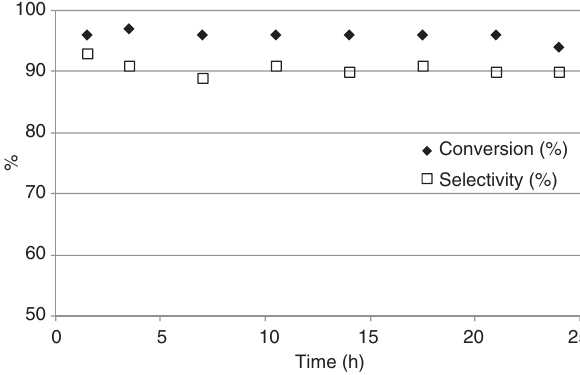
Figure 4: Longevity experiment of imidazole and butanol. Reaction